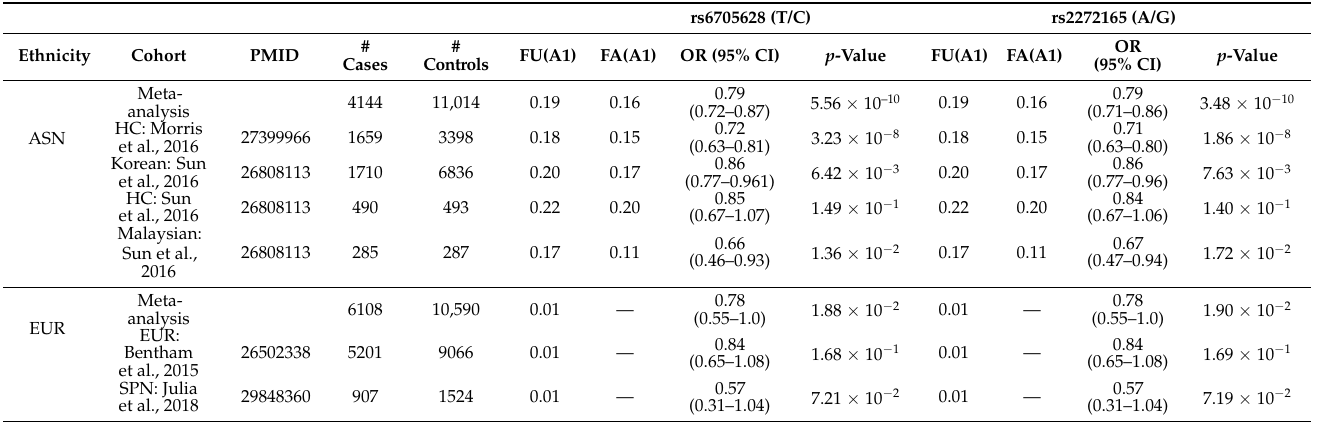
Table 1. Meta-analysis of rs6705628 and rs2272165 at 2p13.1 using Asian and European